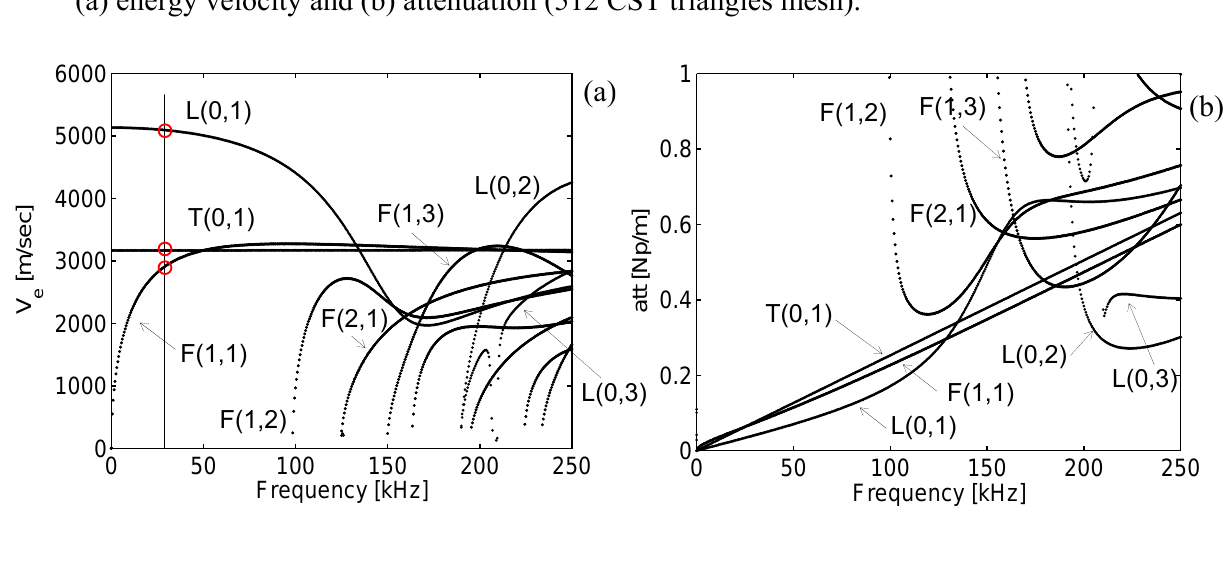
Figure 5 . Dispersion curves for the octagonal bar of overall radius R = 10 mm, in terms of (a) energy velocity and (b) attenuation (512 CST triangles